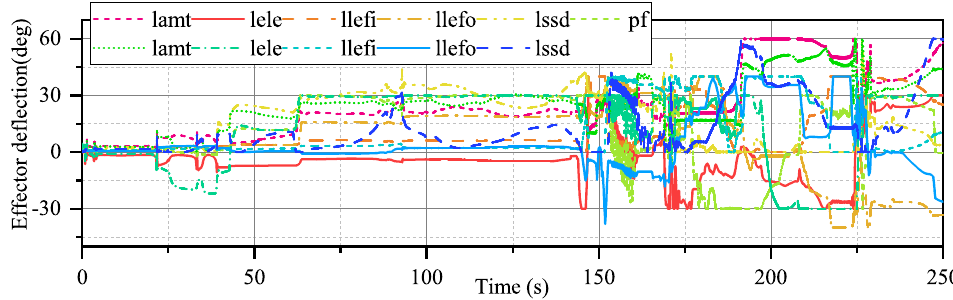
Figure 14. Effector deflections without disturbance.